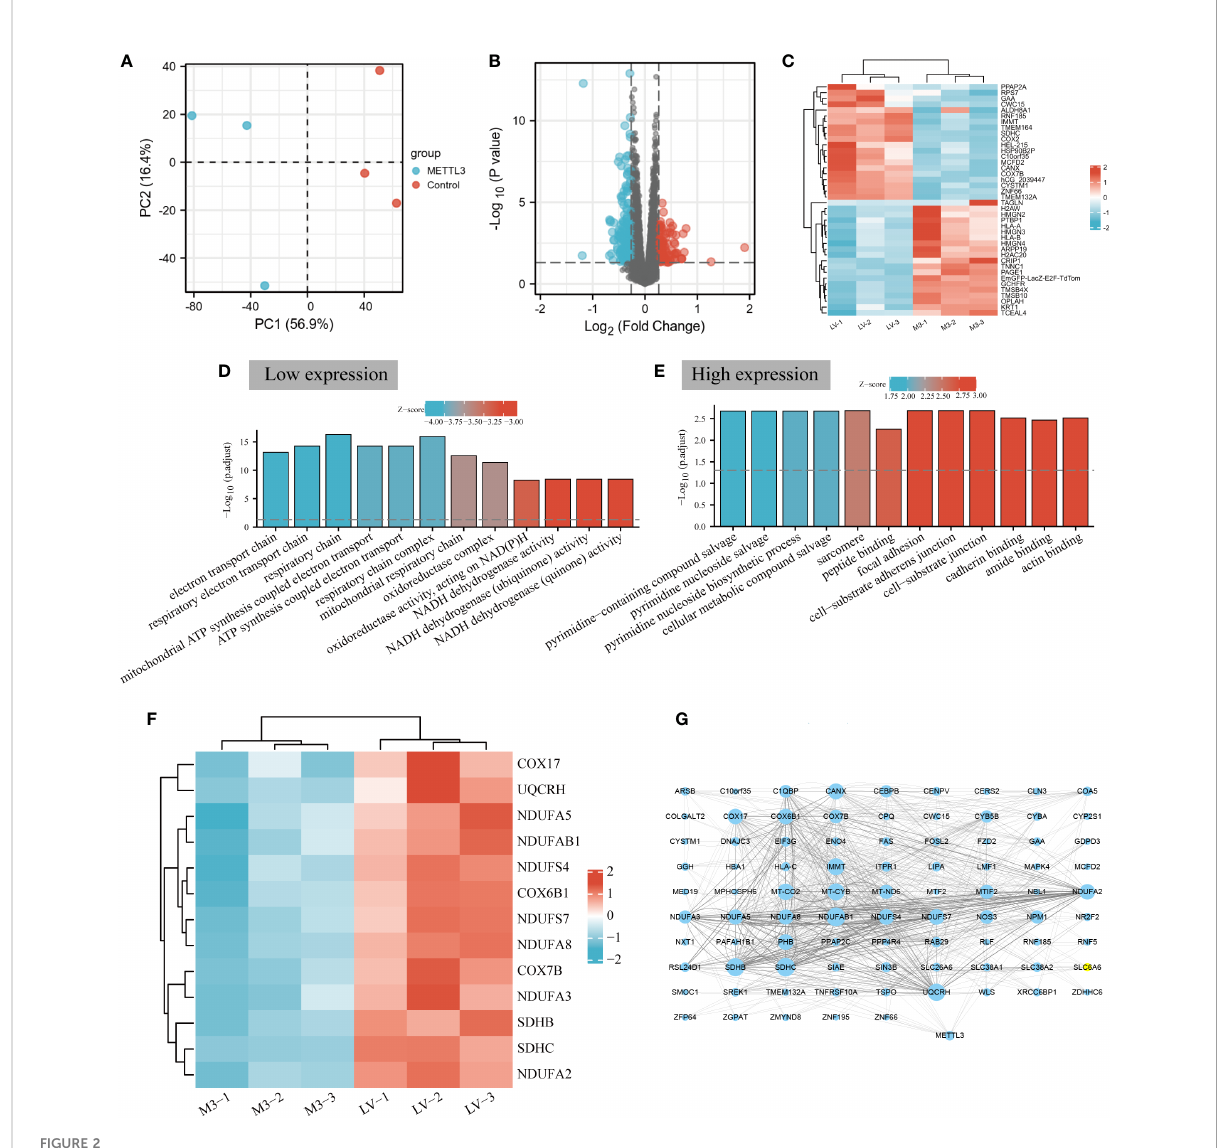
FIGURE 2 METTL3 is involved in cellular energy metabolism in BGC-823 cells. (A) Principal component analysis of METTL3 overexpressd and control samples in BGC-823 cells. (B) Volcano plot analysis of differentially expressed proteins regulated by METTL3, the red and blue dots represent upregulated and downregulated proteins, respectively, and black dots represent no difference. (C) Heatmap of the top 20 most signi fi cantly up-regulation (red) and down-regulation (blue) DEPs. (D) GO enrichment analysis of downregulated proteins. The “ GOplot ” R packet was used to calculate Z-score; a positive Z-score indicated that it may be positive adjustment, while a negative Z-score indicated that it may be a negative adjustment. The larger the absolute value, the higher the degree of regulation. (E) GO enrichment analysis of up-regulated proteins. (F) Heatmap of the number of DEPs and OXPHOS intersecting molecules expressed in GC cells. (G) PPI network diagram of METTL3 and low-expressed DEPs. The larger the area of the dots, the more number of connections between the corresponding nodes and other nodes, the stronger the co-expression